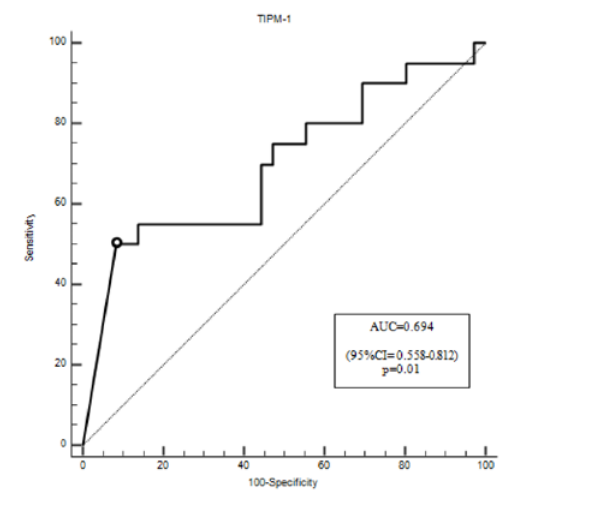
Figure 4: The receiver operating characteristic (ROC) curve for TIMP-1 on ICU day I as a predictor of mortality in critically ill patients. (TIMP, tissue inhibitor of matrix metalloproteinase)